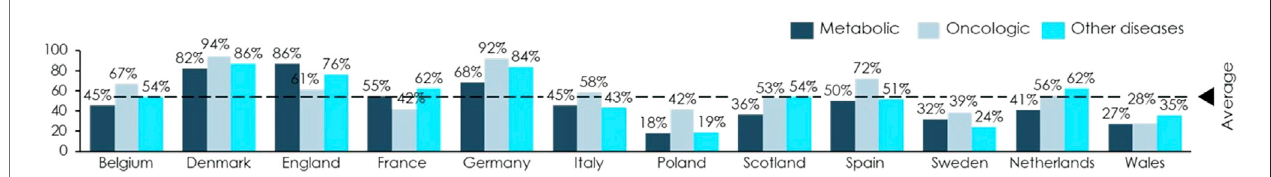
FIGURE 10 | Share of reimbursed OMPs in selected EU Member States, by type of disease. Note: Between January 1995 and May 2000. Source: Copenhagen Economics based on historical average success rates from EMA data (European Medicines Agency 2020). Download medicine data. https://www.ema.europa.eu/en/ medicines/download-medicine-data [Accessed april 21,